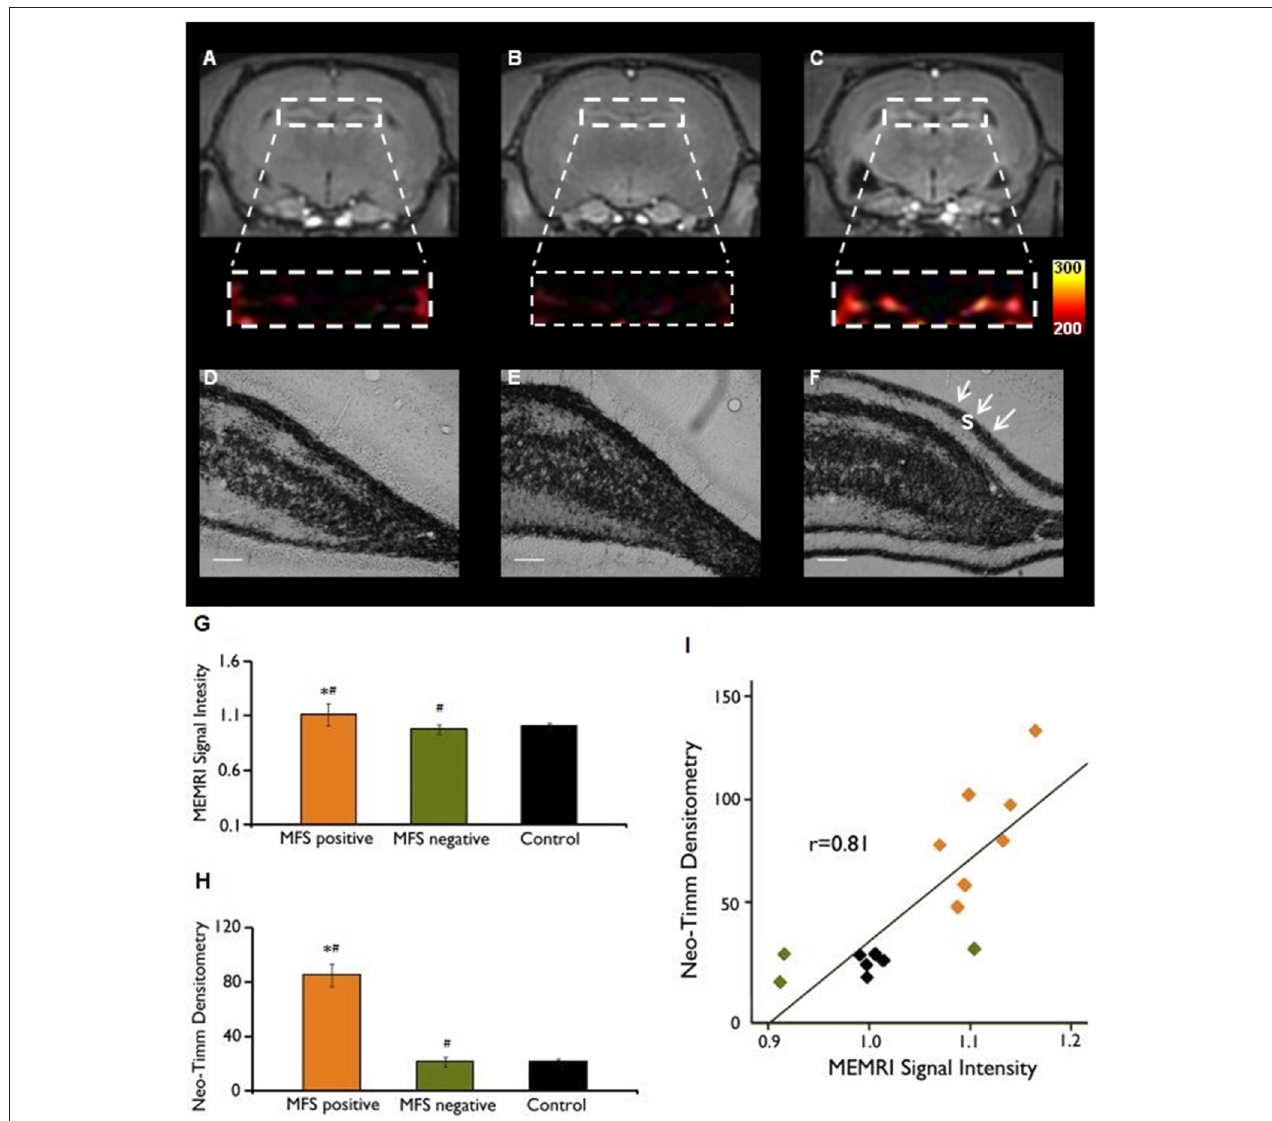
FIGURE 2 | MEMRI and neo-Timm analyses for MFS positive and MFS negative animals. T 1 -weighted Manganese-enhanced MRI (MEMRI) (A–C) and neo-Timm staining (D–F) in Pilocarpine-treated animals. The protein synthesis inhibitor cycloheximide administered before SE onset was able to reduce the mossy fiber sprouting (A) at control levels (B) when compared with the Pilocarpine group (C) . Differences were identified between MFS positive and MFS negative ( # P < 0.05) and MFS positive and control animals (* P < 0.05) (G–H) . Neo-Timm densitometry and MEMRI signal is strongly correlated ( r = 0.81; P < 0,001) in the dispersion graph (I) . s: supragranular mossy fiber sprouting (white arrows in F ). Scale bars = 50 µ m. Modified from our previous study